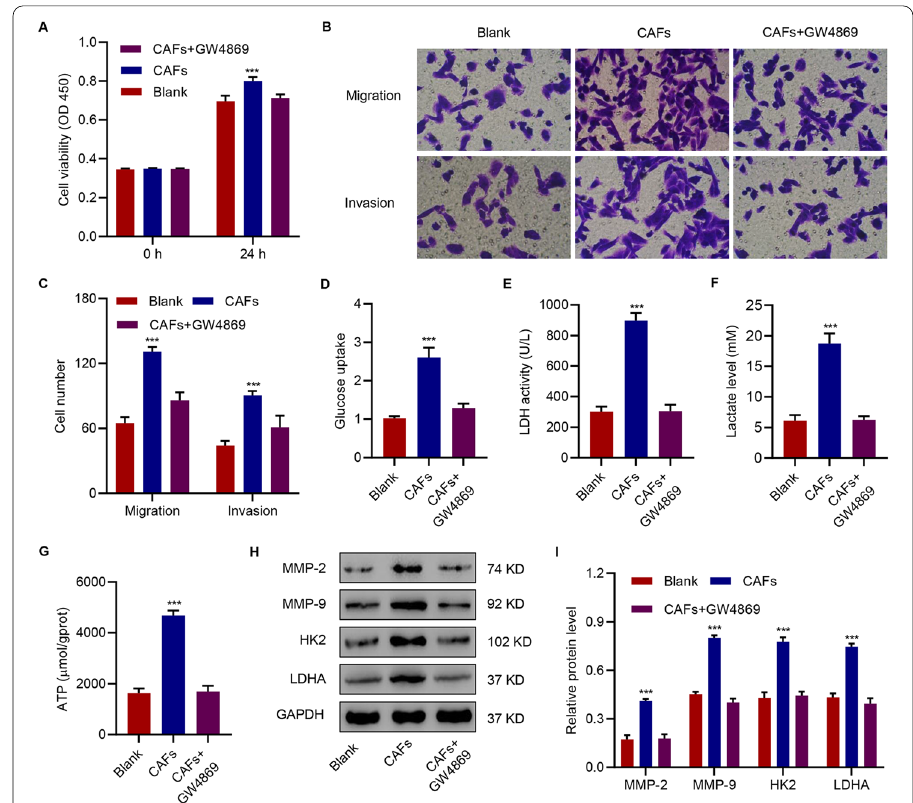
Fig. 2 CAFs-derived exosomes promoted migration, invasion, and glycolysis in HepG2 cells. Effects of CAFs with or without GW4869 on the ( A ) viability, ( B , C ) migration and invasion, ( D ) glucose uptake, ( E ) LDH activity, ( F ) lactate, ( G ) ATP content, and ( H , I ) MMP-2, MMP-9, HK2, and LDHA of HepG2 cells. The data are expressed as the mean SD (n 3). *** P < 0.001 compared with blank (HepG2 cells without ± =